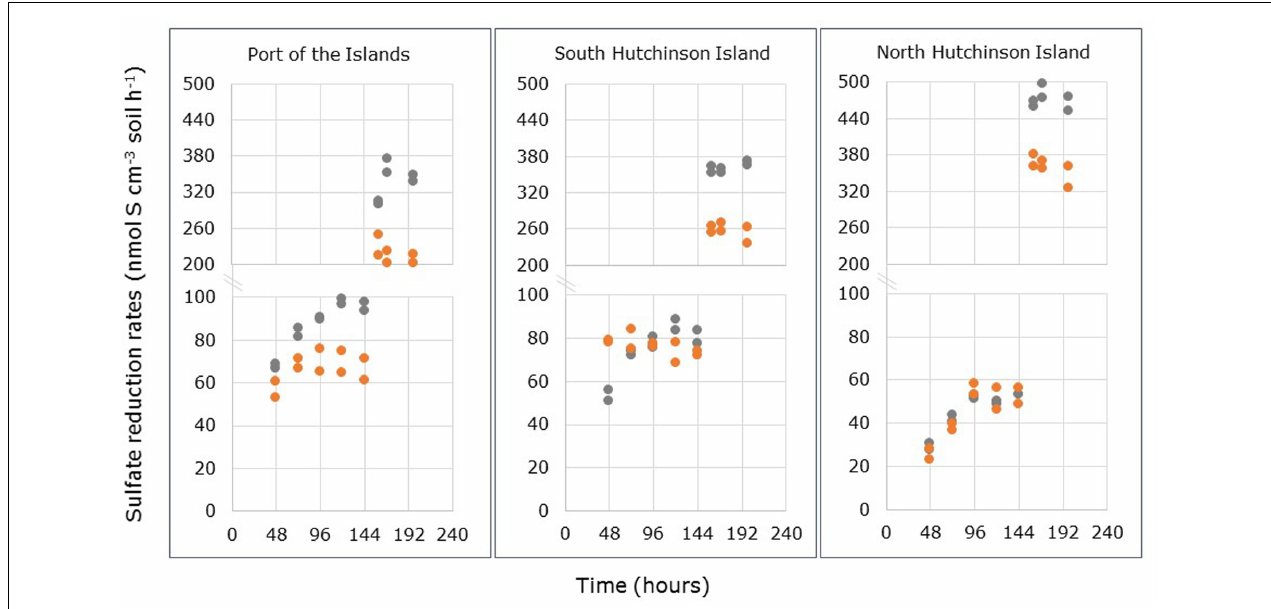
FIGURE 1 | Sulfate reduction rates (SRR) measured in through-flow reactors containing the top 2 cm of intact soil samples collected from Avicennia germinans (gray dots) and Rhizophora mangle stands (orange dots) at Port of the Islands, South Hutchinson Island and North Hutchinson Island. Note the split Y -axes for the points presented after 144